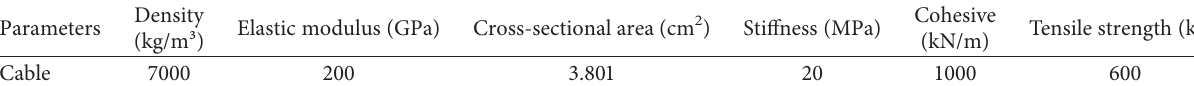
Table 2: Computation parameters of cable.